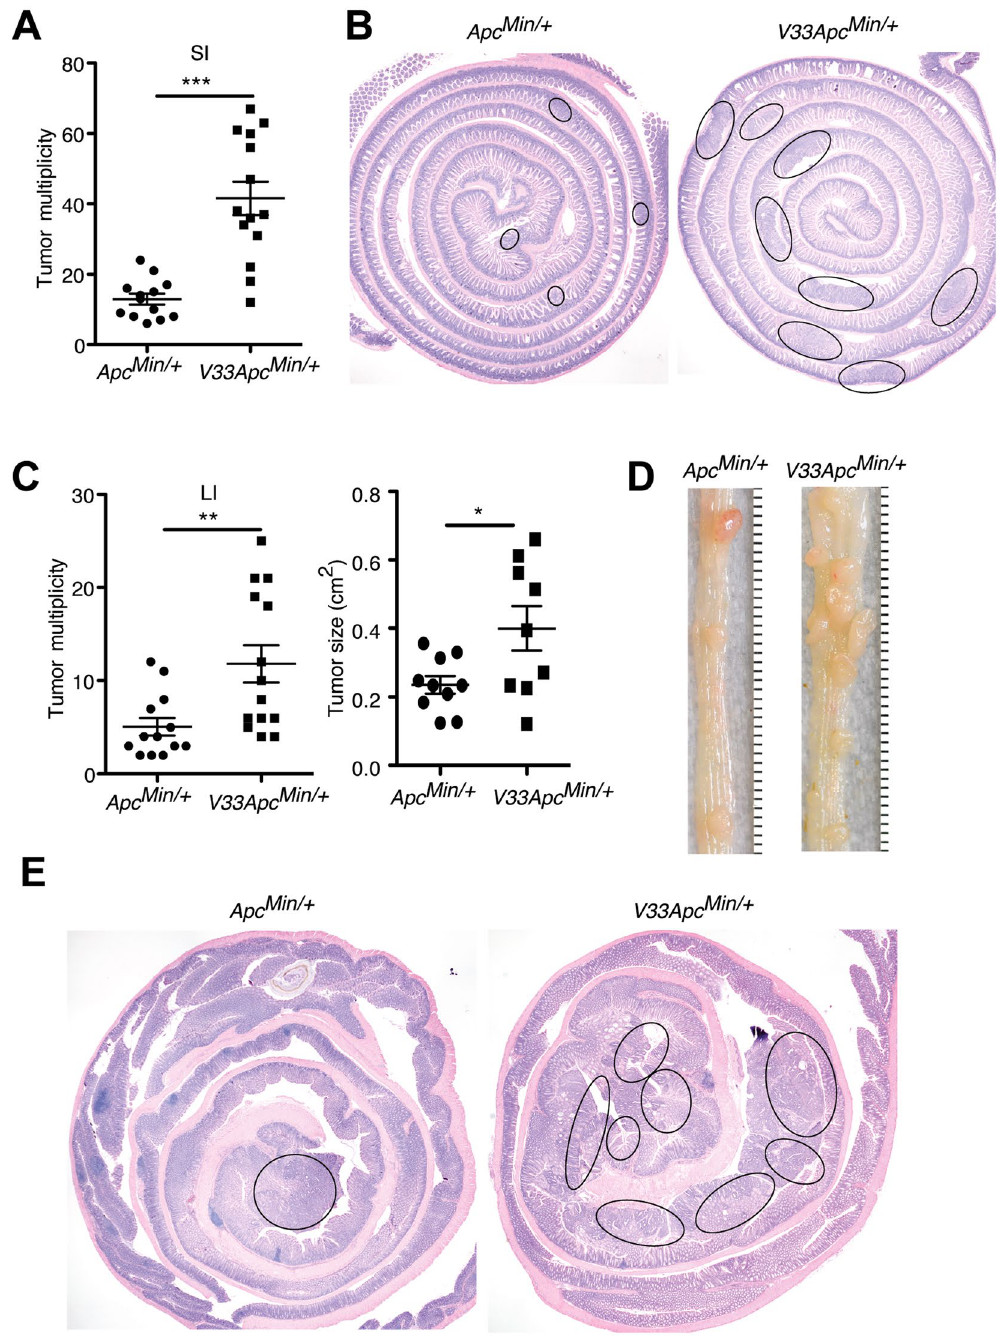
Figure 3. IL-33 promotes intestinal polyp growth in Apc Min/ + mice. ( A ) V33 Apc Min/ + mice carried a significantly higher number of polyps in the SI than Apc Min/ + mice at d120. ( B ) Representative hematoxylin and eosin (H&E) staining of ileum of Apc Min/ + mice and V33 Apc Min/ + mice at d120. Individual tumors are highlighted by black lines. ( C ) Tumor number (left) and tumor size (right) of LI in Apc Min/ + mice and V33 Apc Min/ + mice at d120. ( D ) Representative gross specimens from the indicated genotype analyzed at d120. ( E ) Representative H&E staining of LI of Apc Min/ + mice and V33 Apc Min/ + mice at d120. Individual tumors are highlighted by black lines. Graphs show means ± s.e.m. * P < 0.05, ** P < 0.01, *** P < 0.001, nonparametric Mann-Whitney